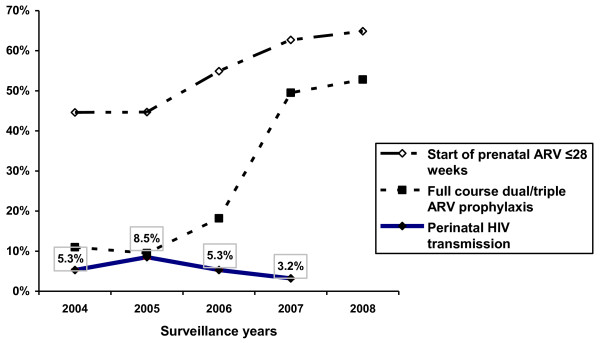
Timing and completeness of antiretroviral prophylaxis and perinatal HIV transmission. Percentage of HIV-infected women who started prenatal ARV ≤28 weeks gestation and received a full course dual/triple ARV prophylaxis, rate of perinatal HIV transmission, St. Petersburg, Russia, 2004-2008, enhanced perinatal HIV surveillance.